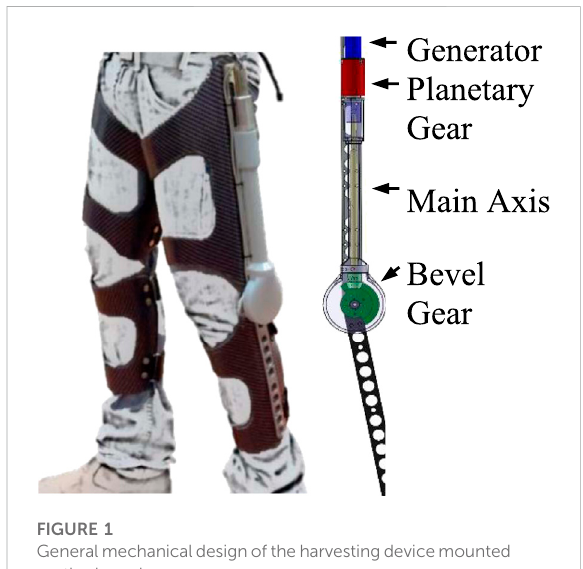
FIGURE 1 Generalmechanicaldesignoftheharvestingdevicemounted on the knee brace.